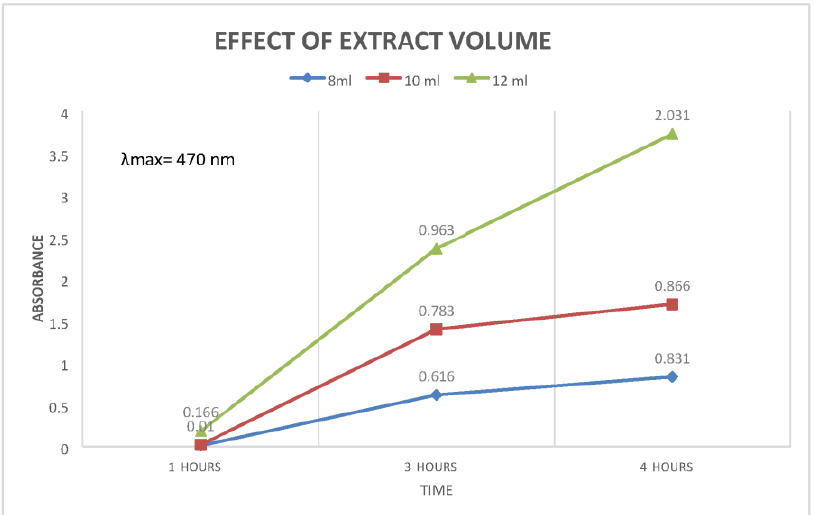
Figure 5. Effect of plant extracts volume on the reaction time. At 3 h, the sample containing the highest quantity of plant extract showed the highest absorbance, recorded at 0.963 at λ max calculated to be 470 nm. The lowest absorbance, 0.616, was shown by the lowest volume of plant extract, 8 mL. At the 4-h mark, the highest was for, once again, the 12 mL of plant extract, showing absorbance of 2.031. The lowest point observed was for the 8 mL plant extract showing absorbance of 0.831.